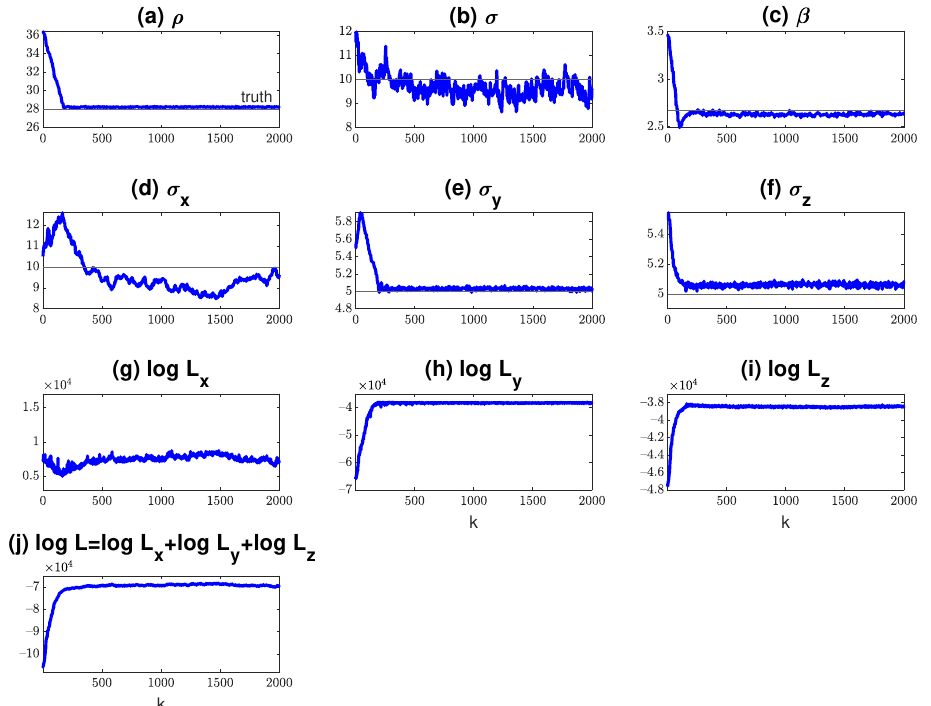
Figure 2. Trace plots of the estimated parameters in the noisy Lorenz 63 model. ( a – f ) the trace plots of each individual parameters ρ , σ , β , σ x , σ y , and σ z . For reference, the true parameters are shown by the black solid lines; ( g ) the trace plot of the log-likelihood for the hidden path of x , according to (6); ( h – i ) the trace plots of the log-likelihood of the observation of y and z , respectively, according to (5); ( j ) the trace plots of the total log-likelihood.